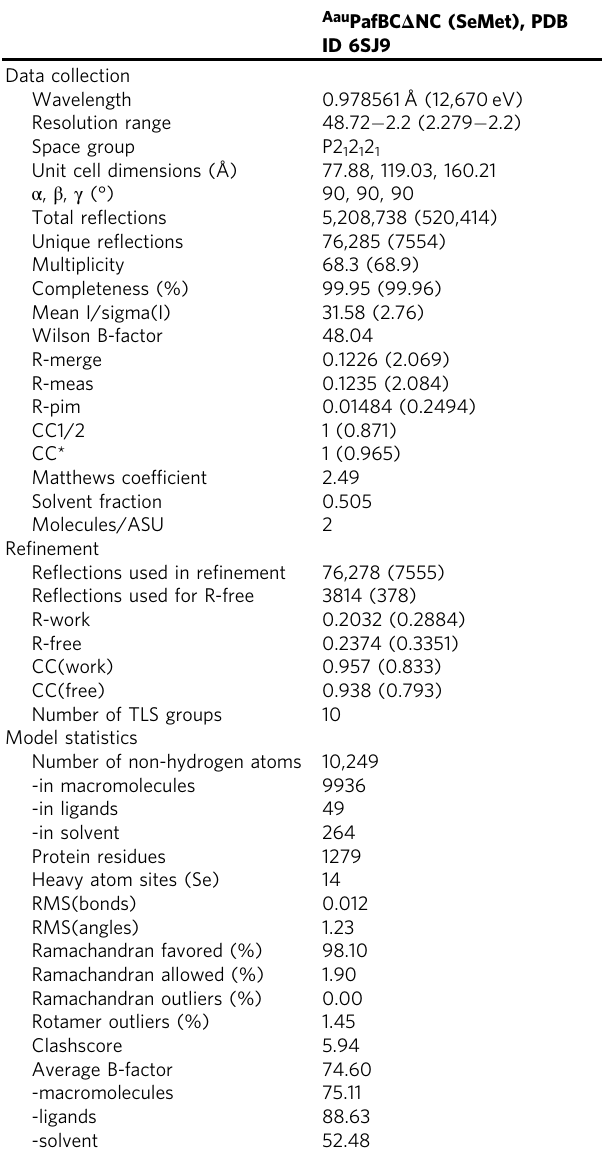
Table 1 Data collection and re fi nement statistics of the crystal structure of Arthrobacter aurescens